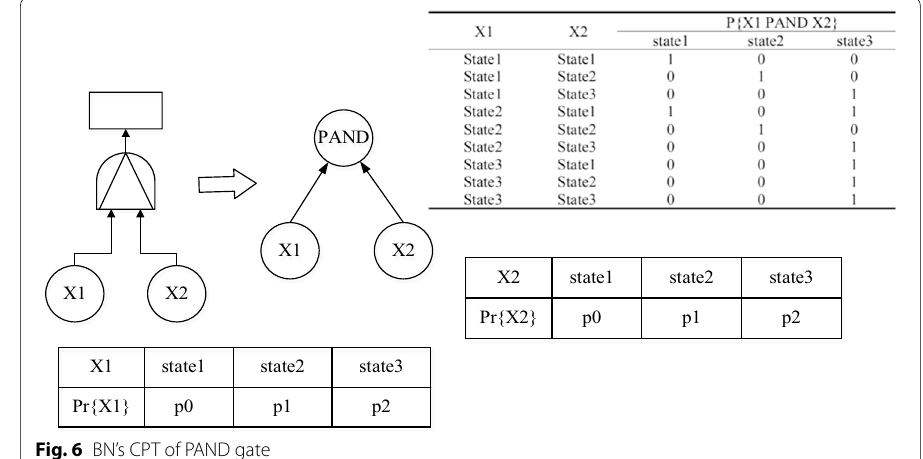
Fig. 6 BN’s CPT of PAND gate